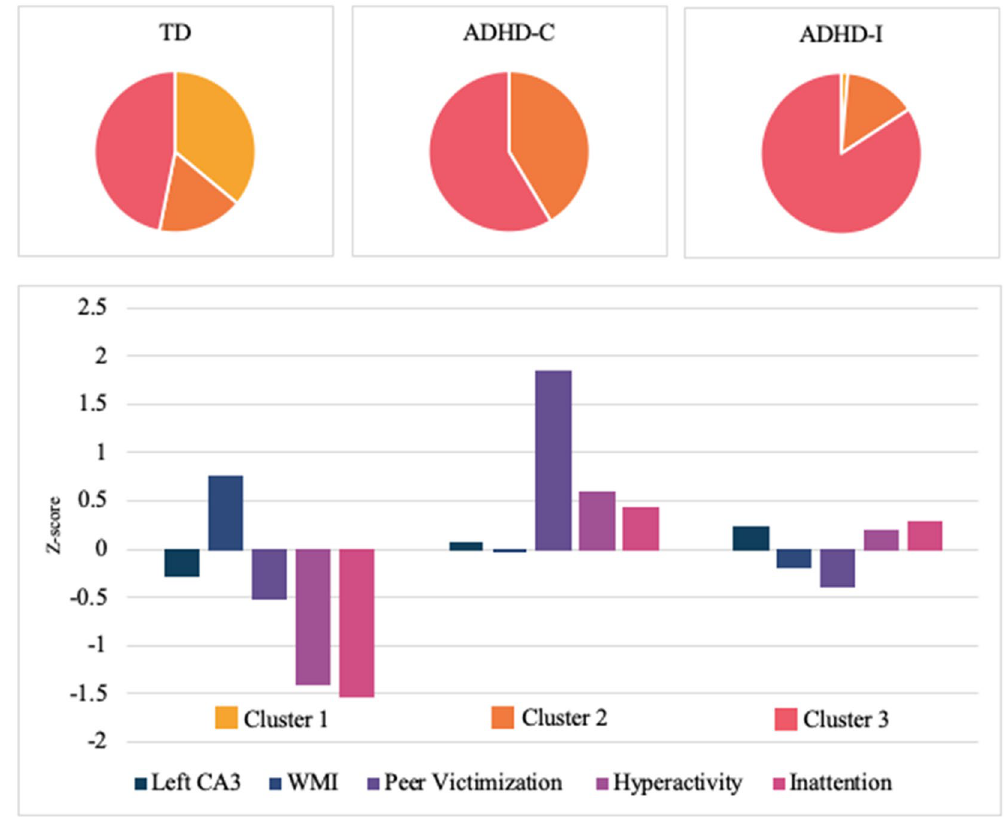
Figure 2. K-means clustering based on peer victimization, left CA3, WMI, hyperactivity-Impulsivity and inattention. The three-cluster model is depicted above. Cluster 1 is characterized by small left CA3 volume, high WMI, low peer victimization, and low hyperactivity-impulsivity and inattention. Cluster 1 is almost entirely made up of TD participants. Cluster 2 is characterized as average left CA3 volumes, average WMI, high peer victimization, and high hyperactivity-impulsivity and inattention. Of the participants in cluster 2, 44% are from the ADHD-C group. Cluster 3 is characterized as large left CA3 volume, low WMI, low peer victimization, and average hyperactivity-impulsivity and inattention. Cluster 3 is approximately 43% ADHD-I participants, 35% TD participants, and 22% ADHD-C